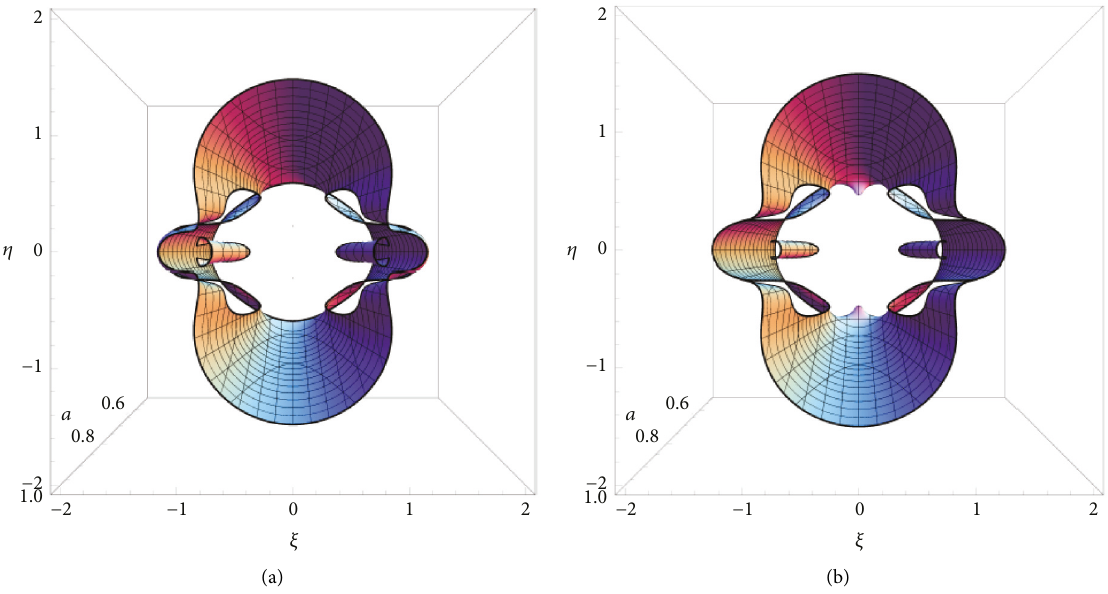
Figure 15: Projection of stability regions (a) b � 0 . 58 and 0 . 5 < a < 1; (b) b � 0 . 60 and 0 . 5 < a < 1.